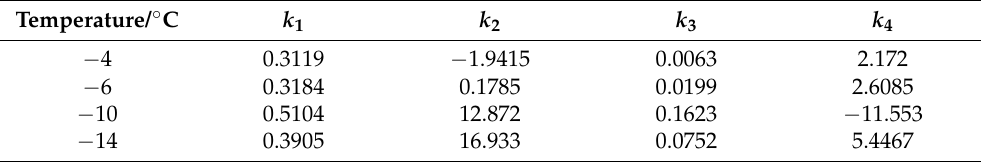
Table 3. Parameters k 1 , k 2 , k 3 , and k 4 under different